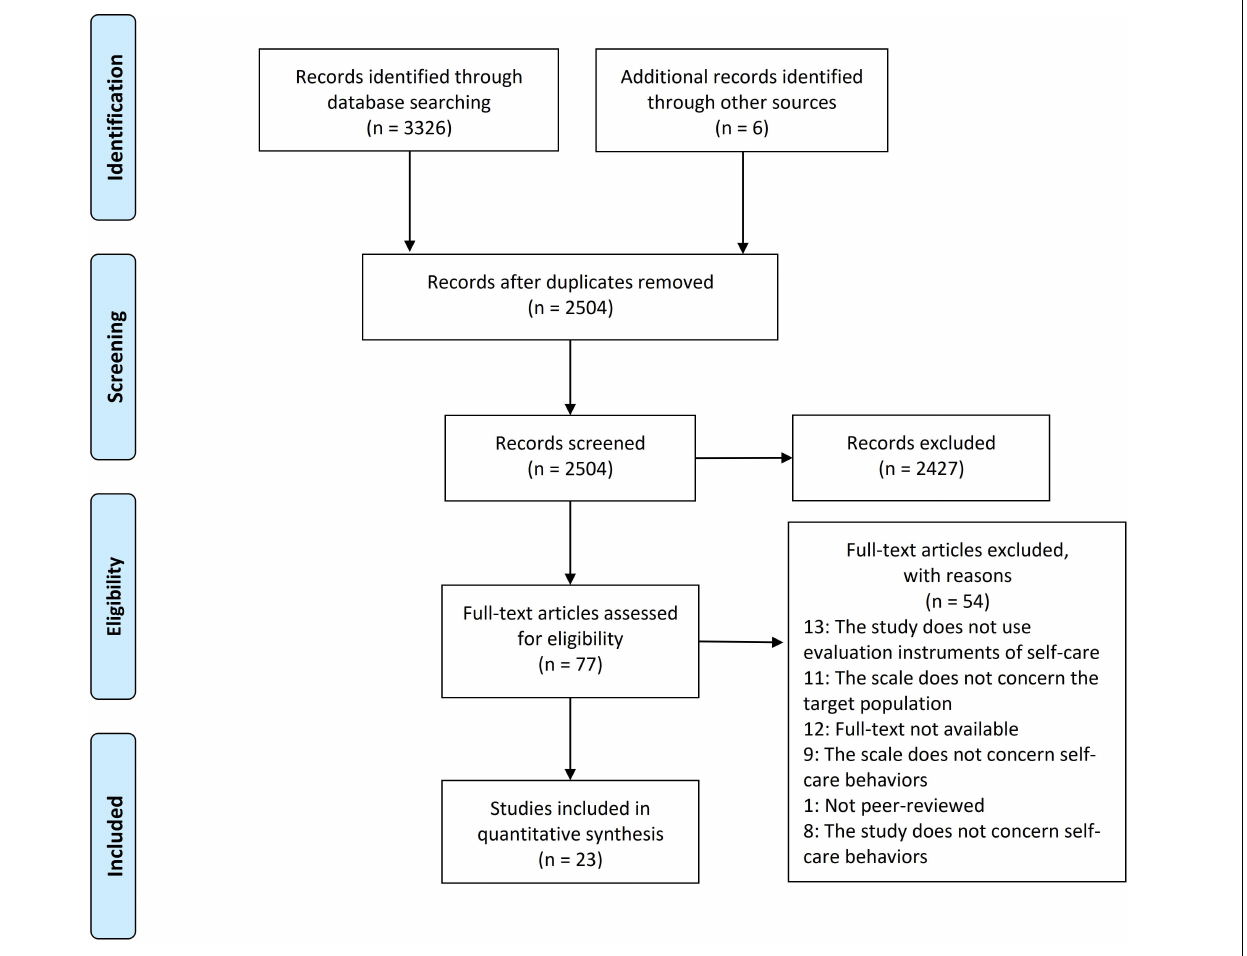
FIGURE 1 | The Preferred Reporting Items for Systematic Review and Meta-Analysis (PRISMA) flow diagram showing the study selection process.